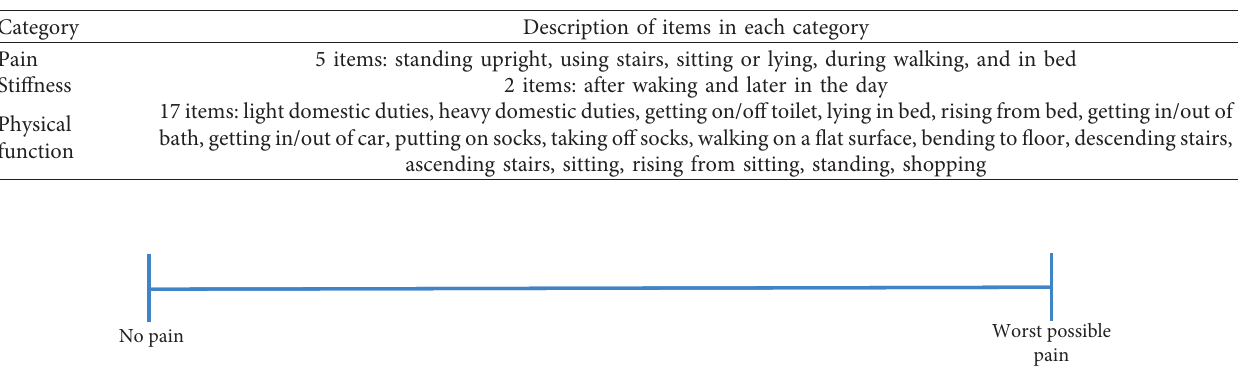
Figure 1: The Visual Analog Scale (VAS), a common measurement tool for pain research. The VAS is a 100 mm long line. A patient will place a single vertical mark on the scale to indicate the intensity of their pain. The mark is then measured and recorded by the caregiver.